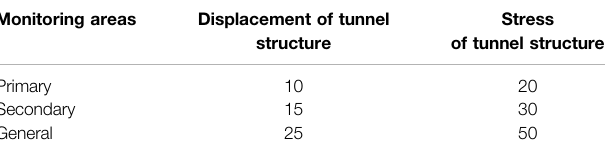
TABLE 3 | Recommended distance between monitoring